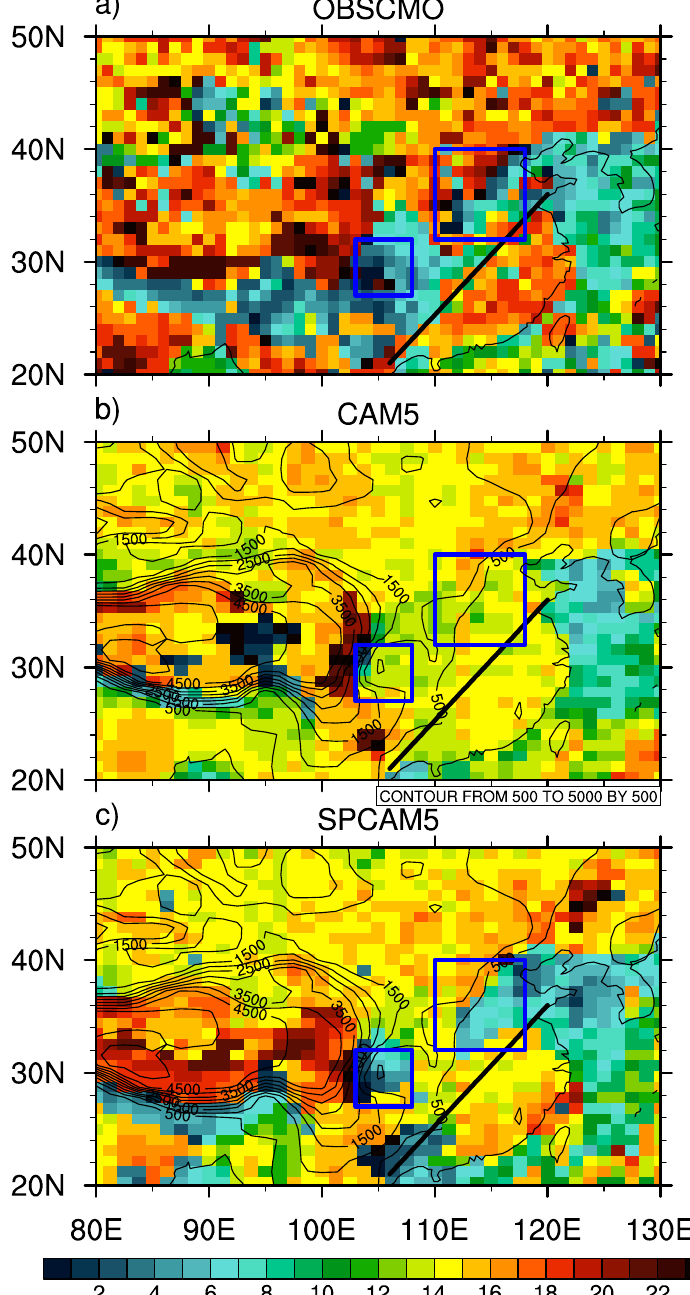
Figure 1. The peak time (local solar time) of rainfall over continental East Asia in, ( a ) a high-resolution (0.1°0.1°) hourly gauge-satellite merged precipitation dataset (OBSCMO), ( b ) (0.1 ◦ 0.1 ◦ ) hourly gauge-satellite merged precipitation dataset (OBSCMO), ( b ) Community Atmosphere Community Atmosphere Model, version 5 (CAM5), and ( c ) Super-Parameterized CAM5 (SPCAM5); Model, version 5 (CAM5), and ( c ) Super-Parameterized CAM5 (SPCAM5); the topography of the model the topography of the model is contoured with thin black lines. The two blue boxes show the regions is contoured with thin black lines. The two blue boxes show the regions that are analyzed in Figure that are analyzed in Figure 2.